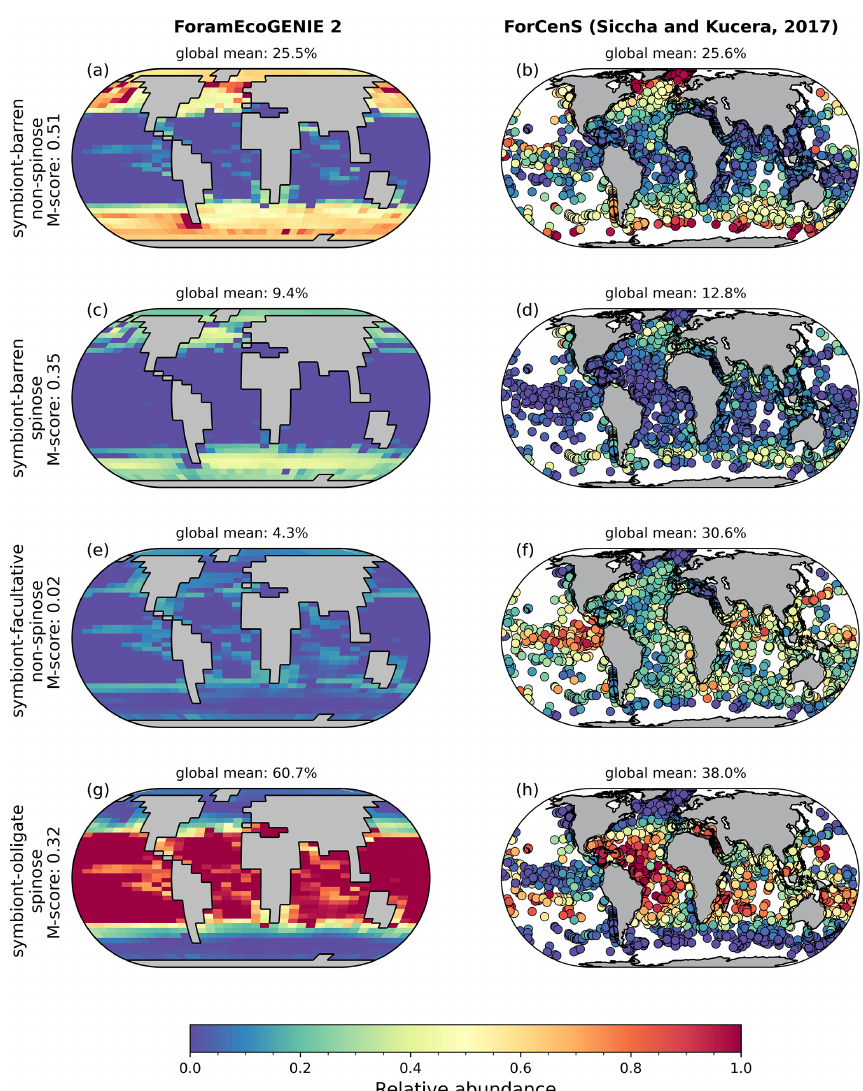
Figure 4. Relative abundance of the four modelled (a, c, e, g) planktic foraminiferal function groups, compared to the ForCenS sediment core-top dataset ( b , d , f , h ; Siccha and Kucera, 2017). Subplot titles show the M-scores derived relative to observations and the global mean of relative